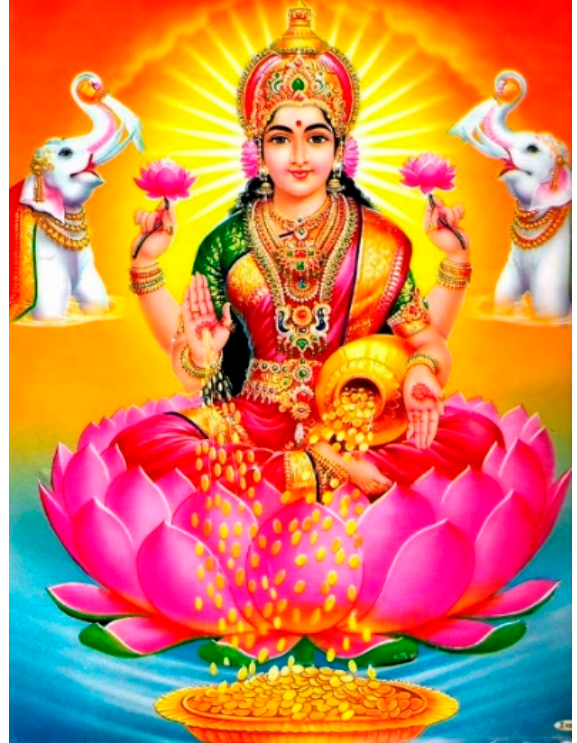
Figure 1. Popular representation of the goddess Lakshmi with her abundant gift of wealth— postcard in private collection of Notermans.